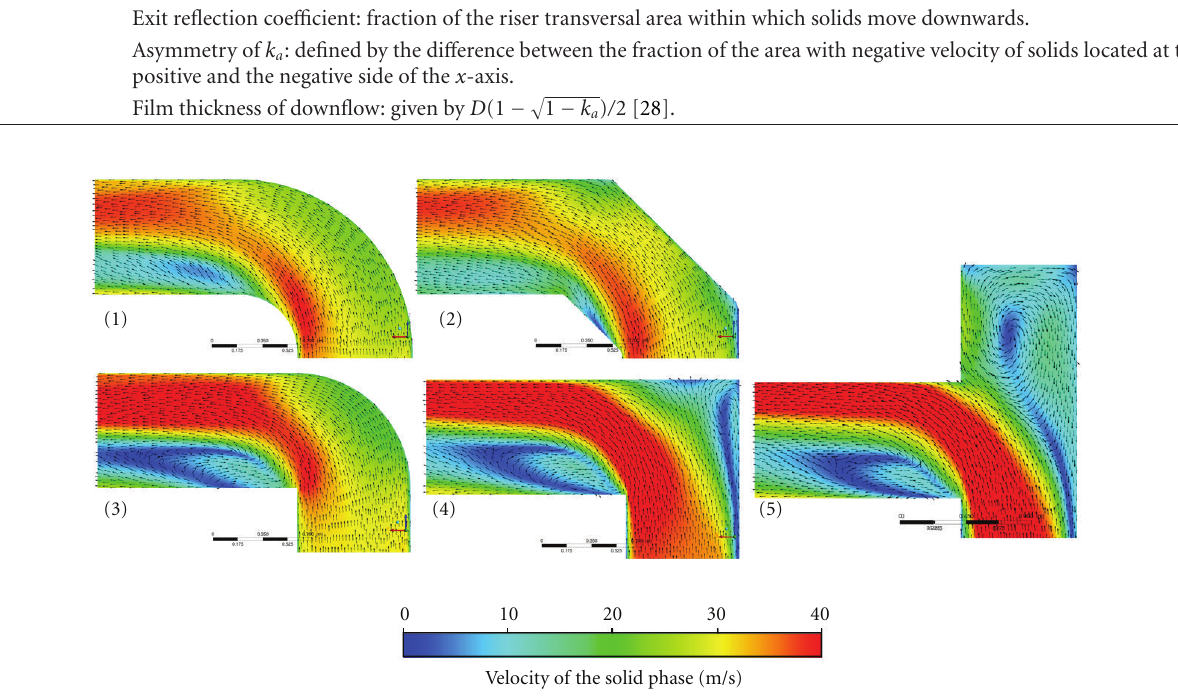
Figure 7: Solid phase velocity and movement.